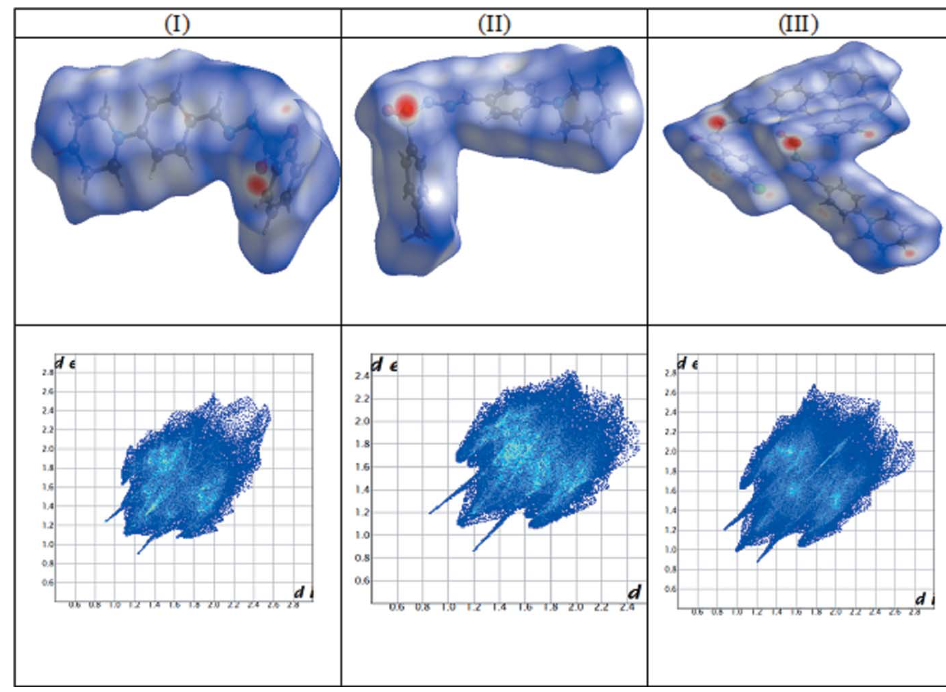
Figure 10 Top: Hirshfeld surface mapped over d norm for (I), (II) and (III). Bottom: two-dimensional fingerprint plots for (I), (II) and (III).